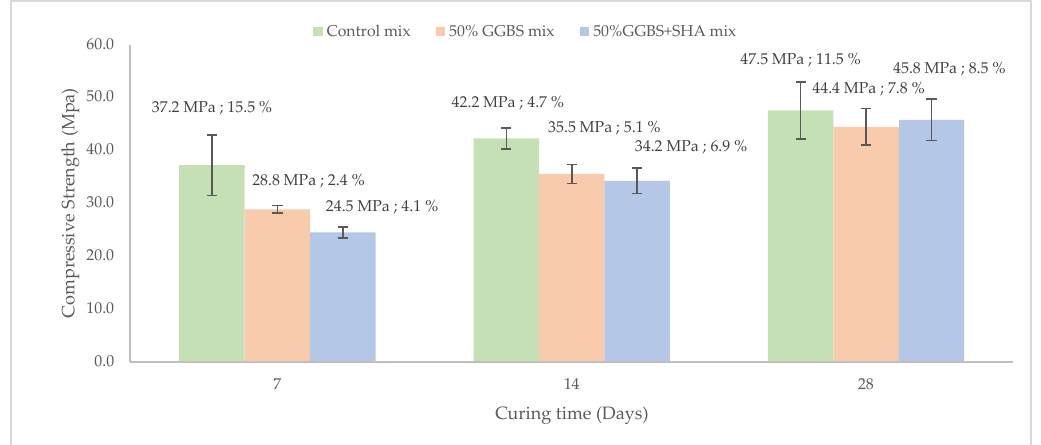
Figure 6. Compressive test—mix comparison (Ultimate compression; Coefficient of variation). In the same Figure 6 , the outcomes of the compressive strength from the 50% GGBS mix are summarised, where throughout the experiment it is observed a 54% gain in com- pression value, starting with 28.8 MPa at the 7-day mark and after 28 days with 44.4 MPa. For these test results, CoVs are smaller than the control mix. The latter values range be- tween 2.4% (7 days) and 7.8% (28 days). With a value of 44.4 MPa at the 28-day mark, this concrete is defined as a C35/45 [44].